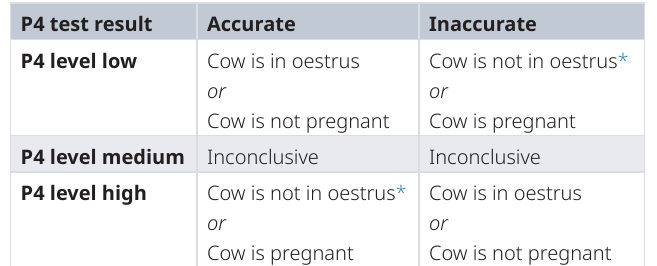
Table 1. Possible scenarios associated with P4 Rapid test results.